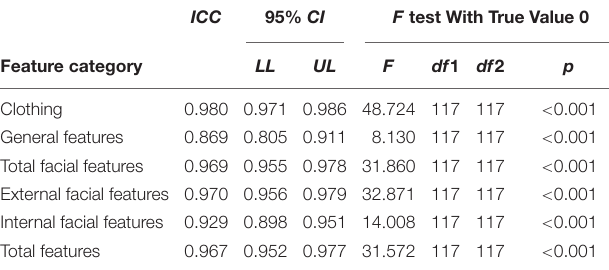
TABLE 3 | Results of the ICC quantification for the statement analysis in study